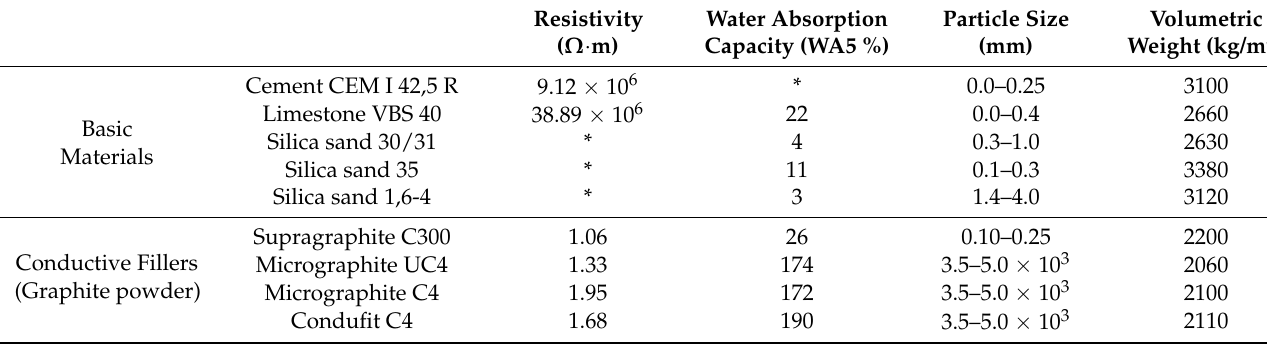
Table 6. Comparison of properties of used